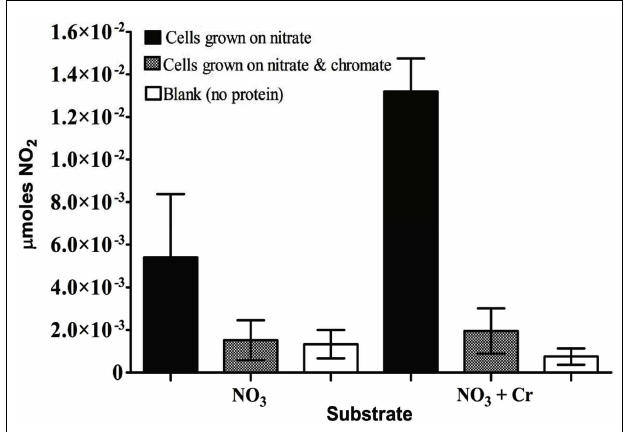
FIGURE 9 |The oxidation of reduced benzyl viologen by S. barnesii lysate in the presence of